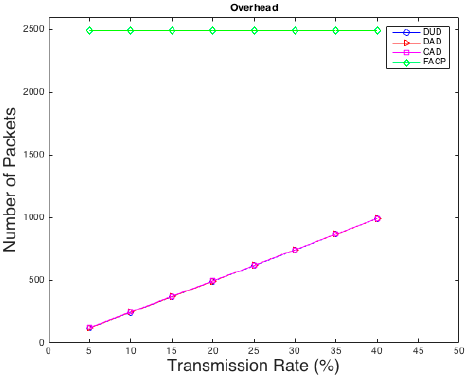
Figure 4. A comparison between the proposed techniques and FACP in case of overhead.